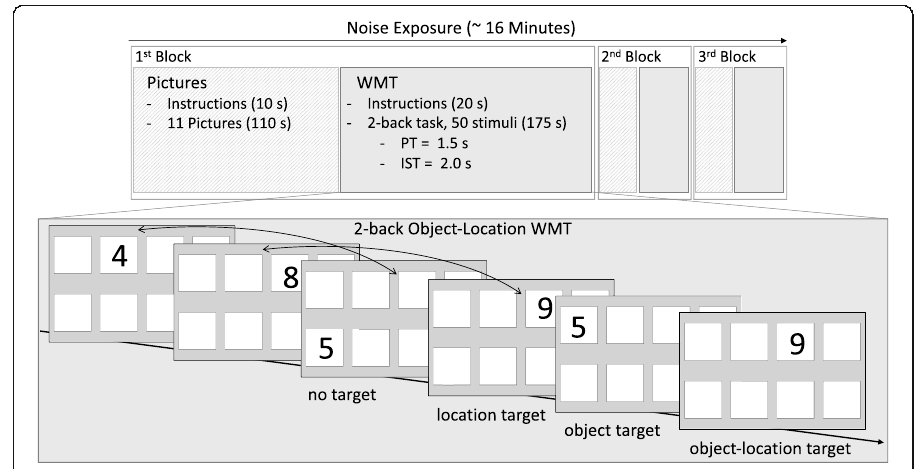
Fig. 1 Procedure of the experimental noise exposure. One session consisted of three blocks with each block being divided into a pictures-viewing part and a working memory task. Participants had to press a yes button if either the current number and/or the box was the same as two steps before (targets). If not, a no button had to be pressed. WMT, working memory task; PT, presentation time; IST, interstimulus